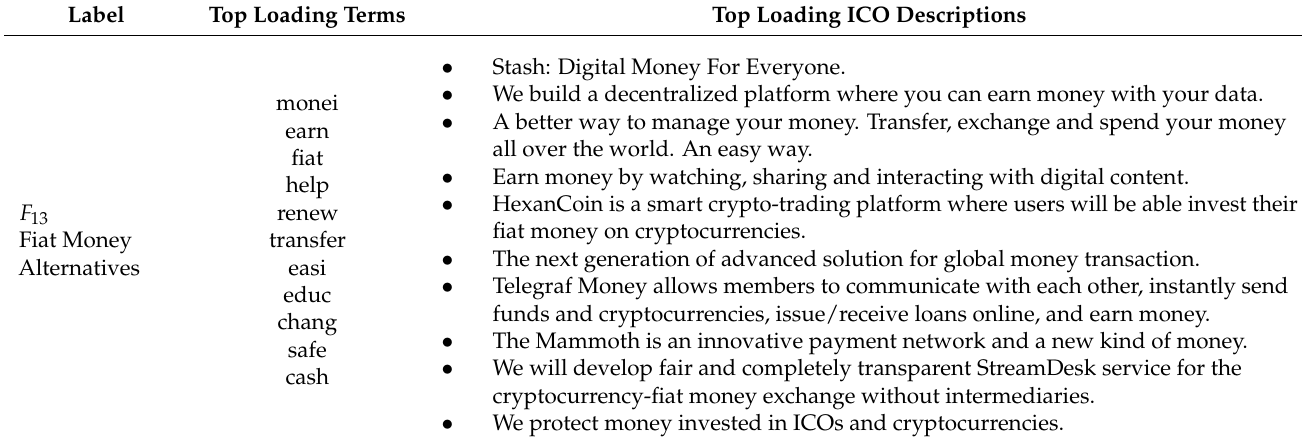
Table A13. Fiat Money Alternatives.